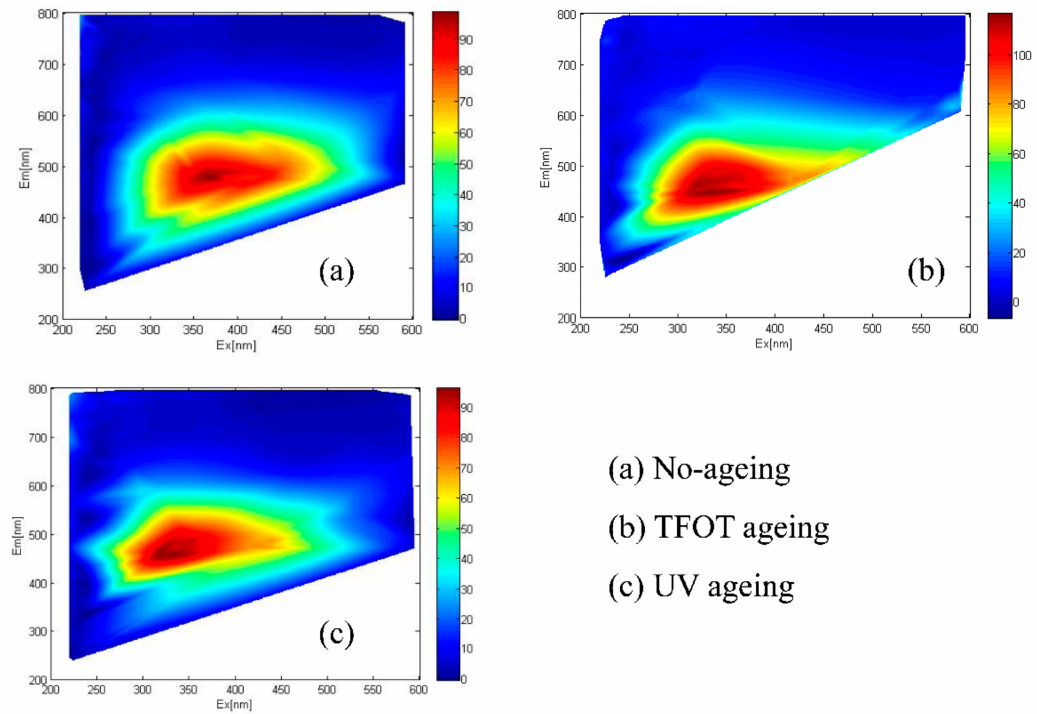
Figure 7. 3D fluorescence spectrum of PJ-90 bitumen: ( a ) No-ageing; ( b ) TFOT ageing; ( c ) UV ageing. There were two obvious characteristic lines like a wathet blue glow, which was visible rising diagonally up to the right in the above images. For the first line, it was easy to see that the excitation wavelength (EX) of this line was equal to the emission wavelength (EM), the phenomenon is